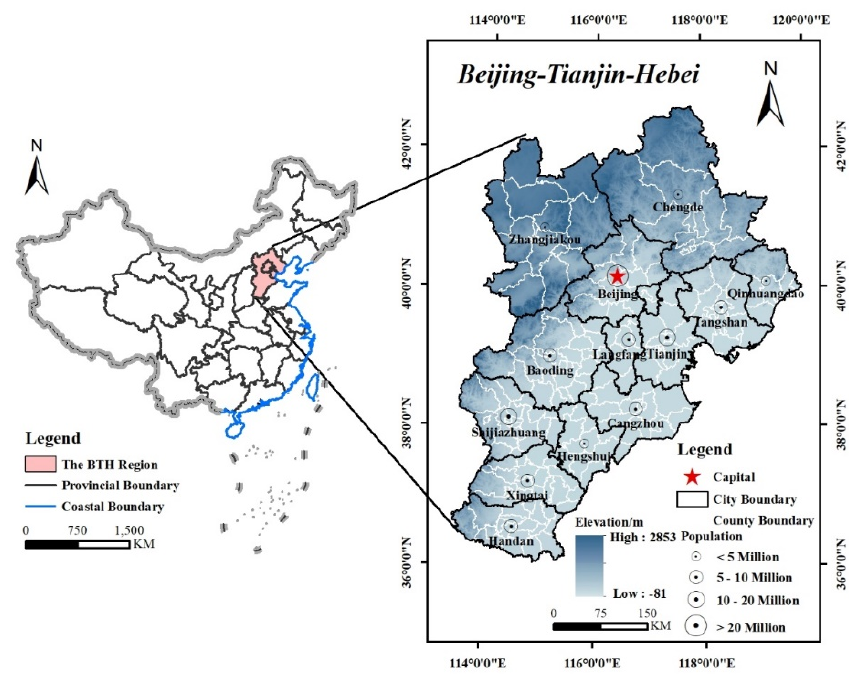
Figure 1. Location of the study area.